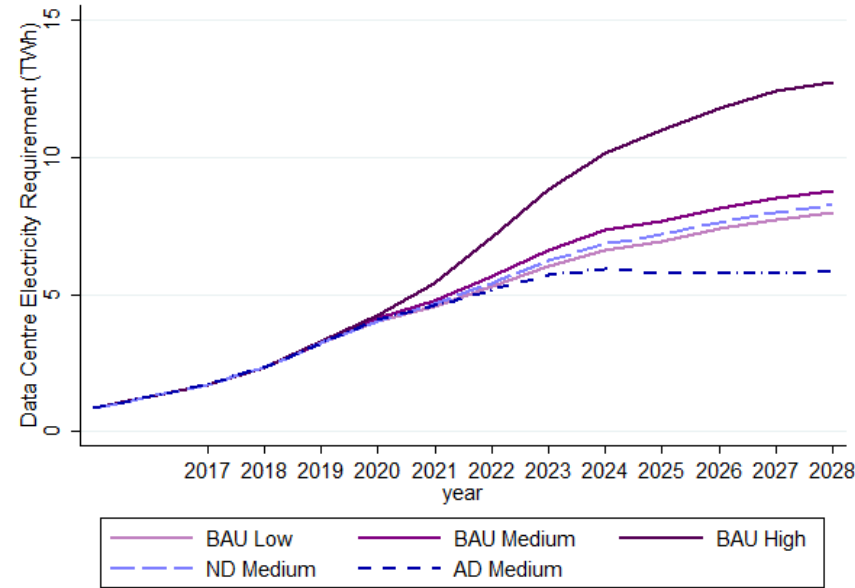
Figure 4. Data centre sector electricity consumption (TWh). Source: Author’s calculations based on EirGrid [53] data. Note: Assumes a data centre capacity factor of